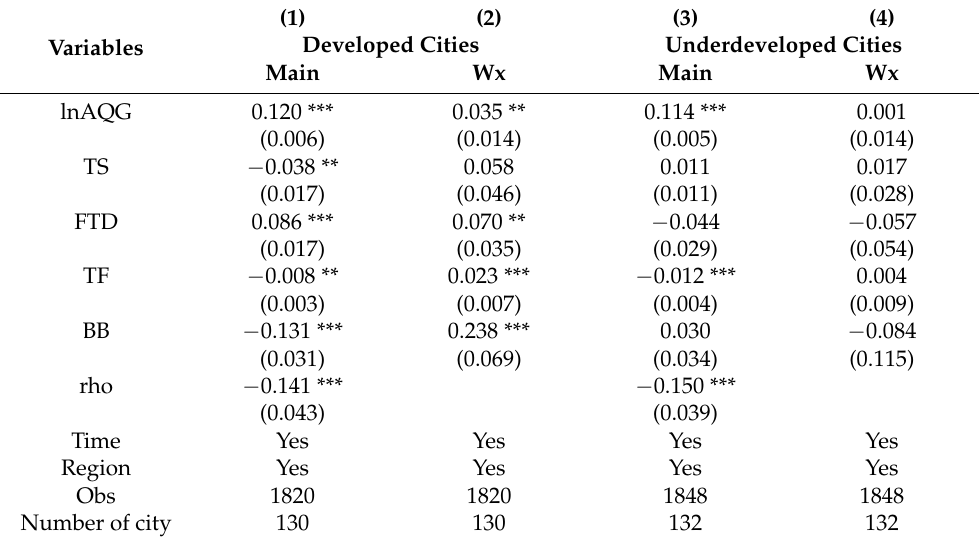
Table 9. Effect of air pollution governance on labor productivity given different urban development levels.